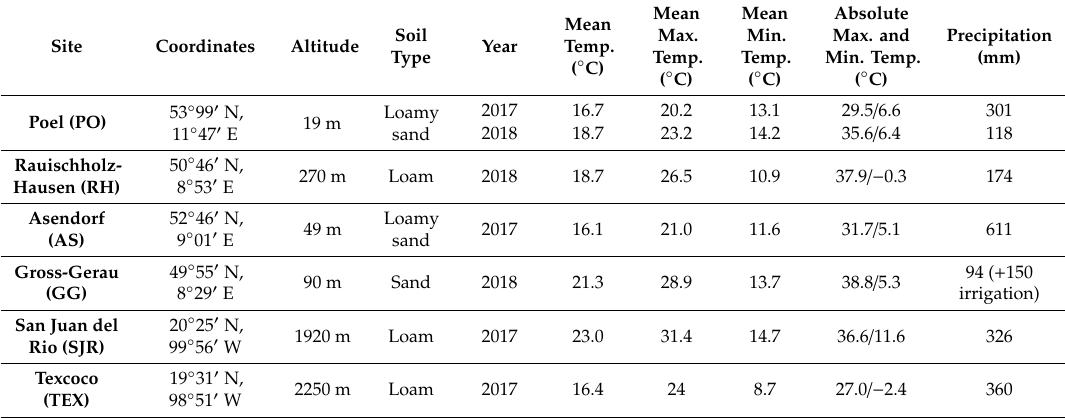
Table 1. Overview and climate data of the di ff erent environments during the duration of the experiments (from sowing until harvest of the panicles, i.e., May until September or October).